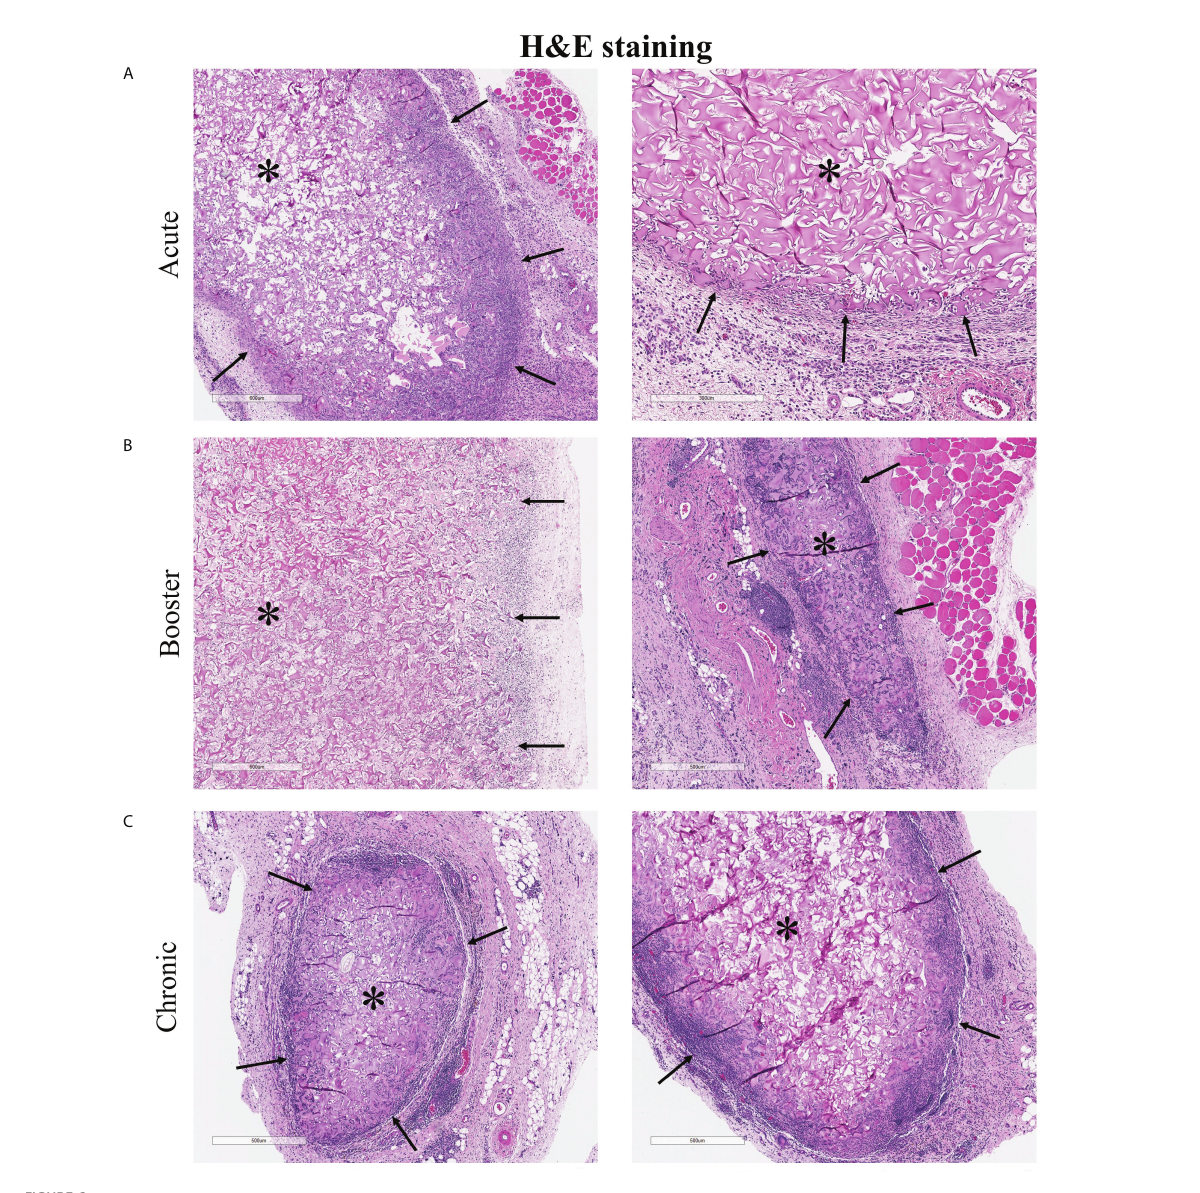
FIGURE 6 H&E staining of explanted 3D cellularized scaffolds. (A – C) Histology shows immune cell in fi ltration, fi brous encapsulation, and increased vascularization in and around scaffolds. Immune cells penetrated 165 ± 66 µm into the acute scaffolds and 227 ± 28 µm into the chronic scaffolds. Stars (*) denotes encapsulated scaffolds surrounded by immune cells, black arrows ( ! ) point to scaffold-tissue interface and the direction of in fi ltrating host cells. Images from two different rats, representative of six rats per time